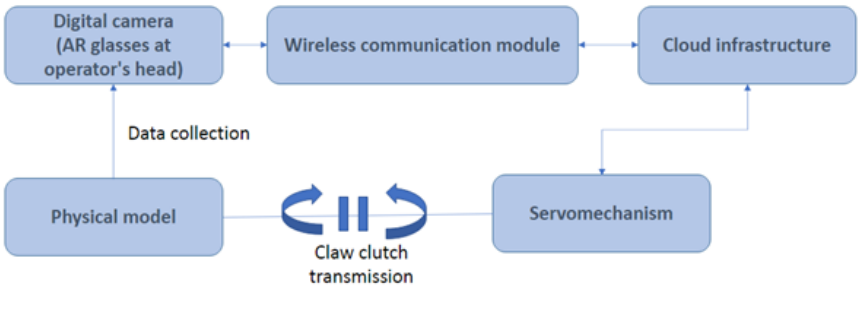
Figure 1. Schematic diagram of a measurement